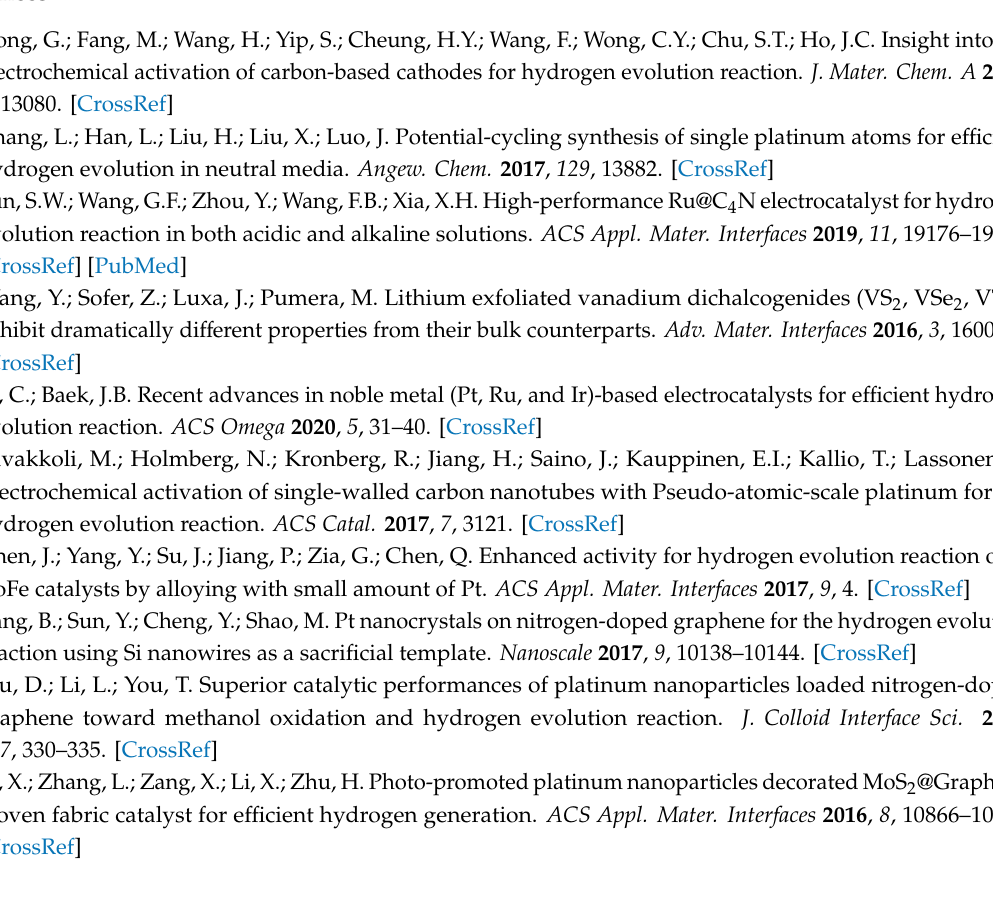
s1, Figure S1: Optical image and SEM image of WTe 2 single crystal for the electrochemical measurements, Figure S2: Residual resistance ratio (RRR) of three TMTe 2 single